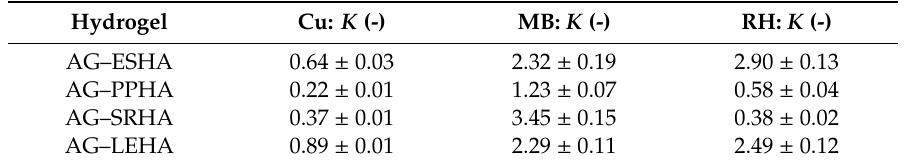
Table 3. Values of the apparent equilibrium constants K determined on the basis of Equation (8).